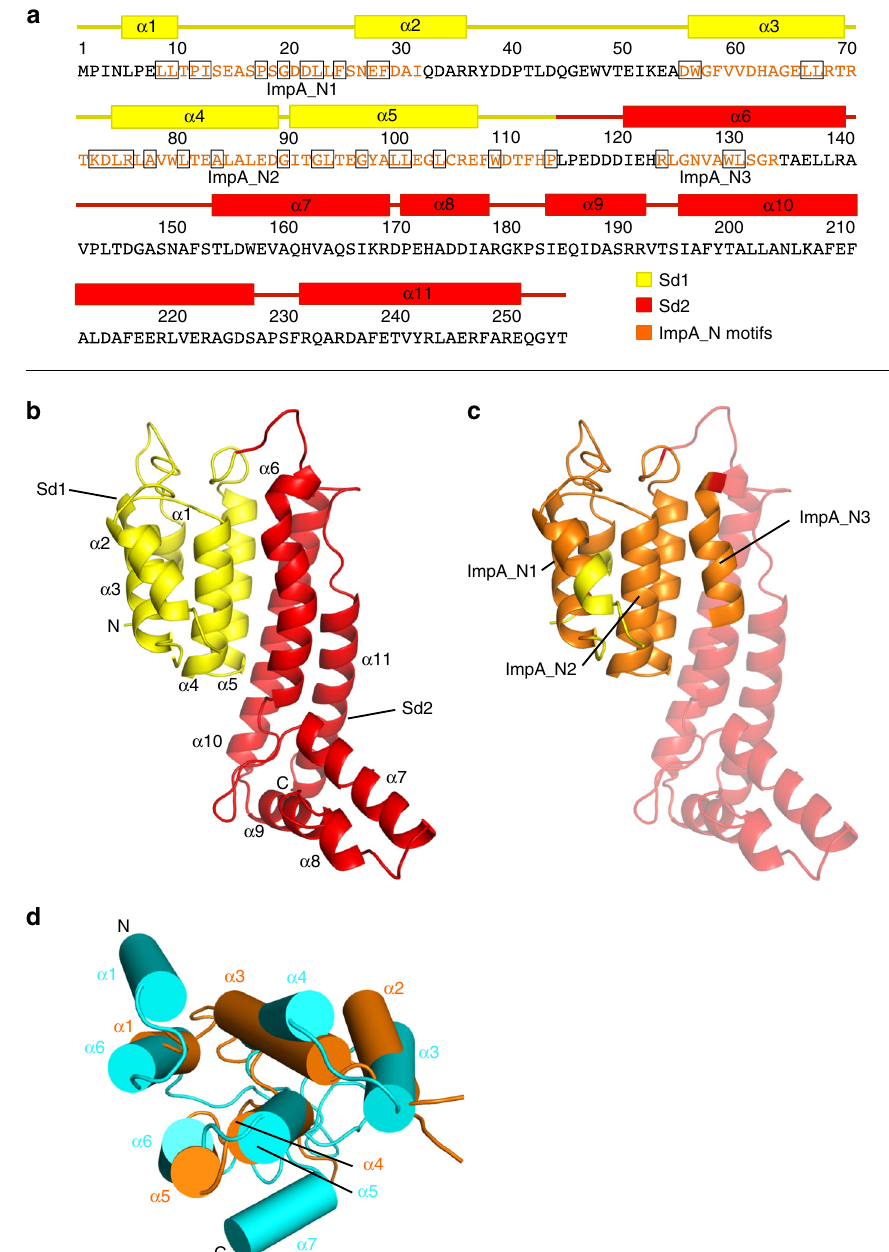
Fig. 4 High-resolution structure of Bc TssA1 B Nt1 and its similarity to Ah TssA2 Nt2. a Bc TssA1 B Nt1 sequence annotated to show the elements of secondary structure. Location of α -helices are shown by coloured rectangles above the amino acid sequence with the region corresponding to Sd1 highlighted in yellow and Sd2 highlighted in red. The three ImpA_N motifs are indicated in orange font and conserved ImpA_N domain residues (see Supplementary Fig. 1) are shown in black boxes. b X-ray structure of Bc TssA1 B Nt1 (PDB: 6HS5 https://www.ebi.ac.uk/pdbe/entry/pdb/6hs5). The two subdomains, Sd1 and Sd2, are shown in yellow and red, respectively. c X-ray structure of Bc TssA1 B Nt1 represented as in (b) showing location of ImpA_N1- ImpA_N3 regions in orange. For clarity, the helices of Sd2 ( α 6- α 11) located C-terminal to ImpA_N3 are made more transparent than those in Sd1. d Bc TssA1 B Sd1 (orange) superimposed on the Ah TssA2 A Nt2 domain (PDB: 6G7B https://www.ebi.ac.uk/pdbe/entry/pdb/6g7b; cyan) showing the